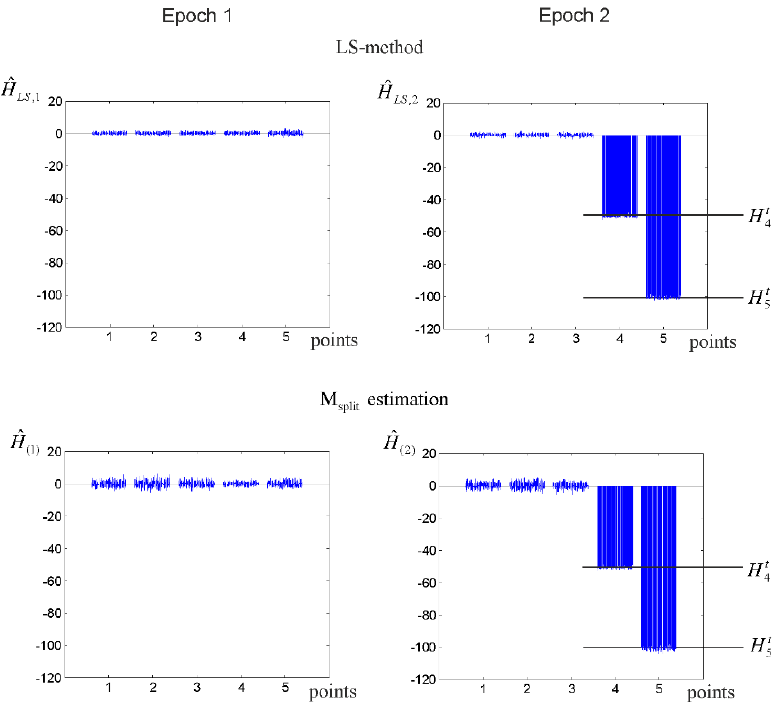
∆ H = − 50 and ∆ H 50 H   and 4 ( 1,2 ) 4 ( 1 , 2 )